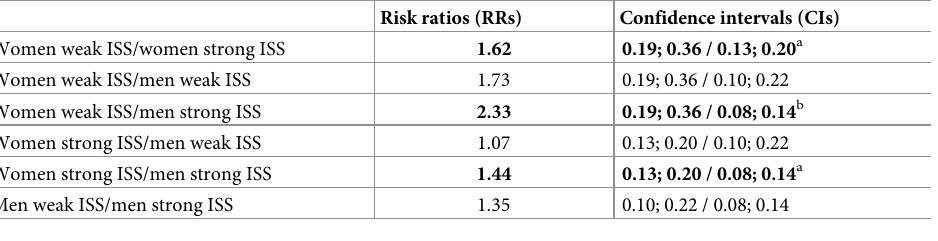
Table 4. Risk ratios (RRs) and confidence intervals (CIs) for frequent pain at follow-up, associated with baseline instrumental social support (ISS) among all possible combinations of ISS and sex. Risk ratios (RRs) Confidence intervals (CIs) Women weak ISS/women strong ISS